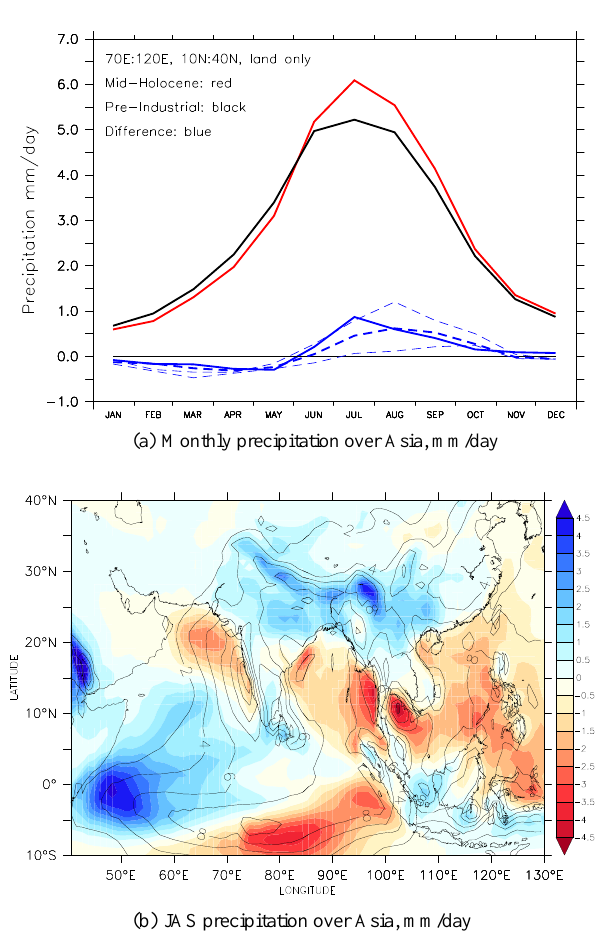
Fig. 9. Figure (a): Precipitation (mm/day) for PI (black), MH (red) and difference MH-PI (blue) throughout the year. The dashed blue lines are differences in the PMIP2 models: the thick dashed blue line is the average of 12 PMIP2 models (see Figure 15 for refer- ences). The thin dashed blue lines are individual PMIP2 model re- sults with the largest and smallest changes for Asia in JAS. Figure (b): the spatial pattern of precipitation differences in JAS. Colours indicate MH - PI differences, contours are absolute PI values.